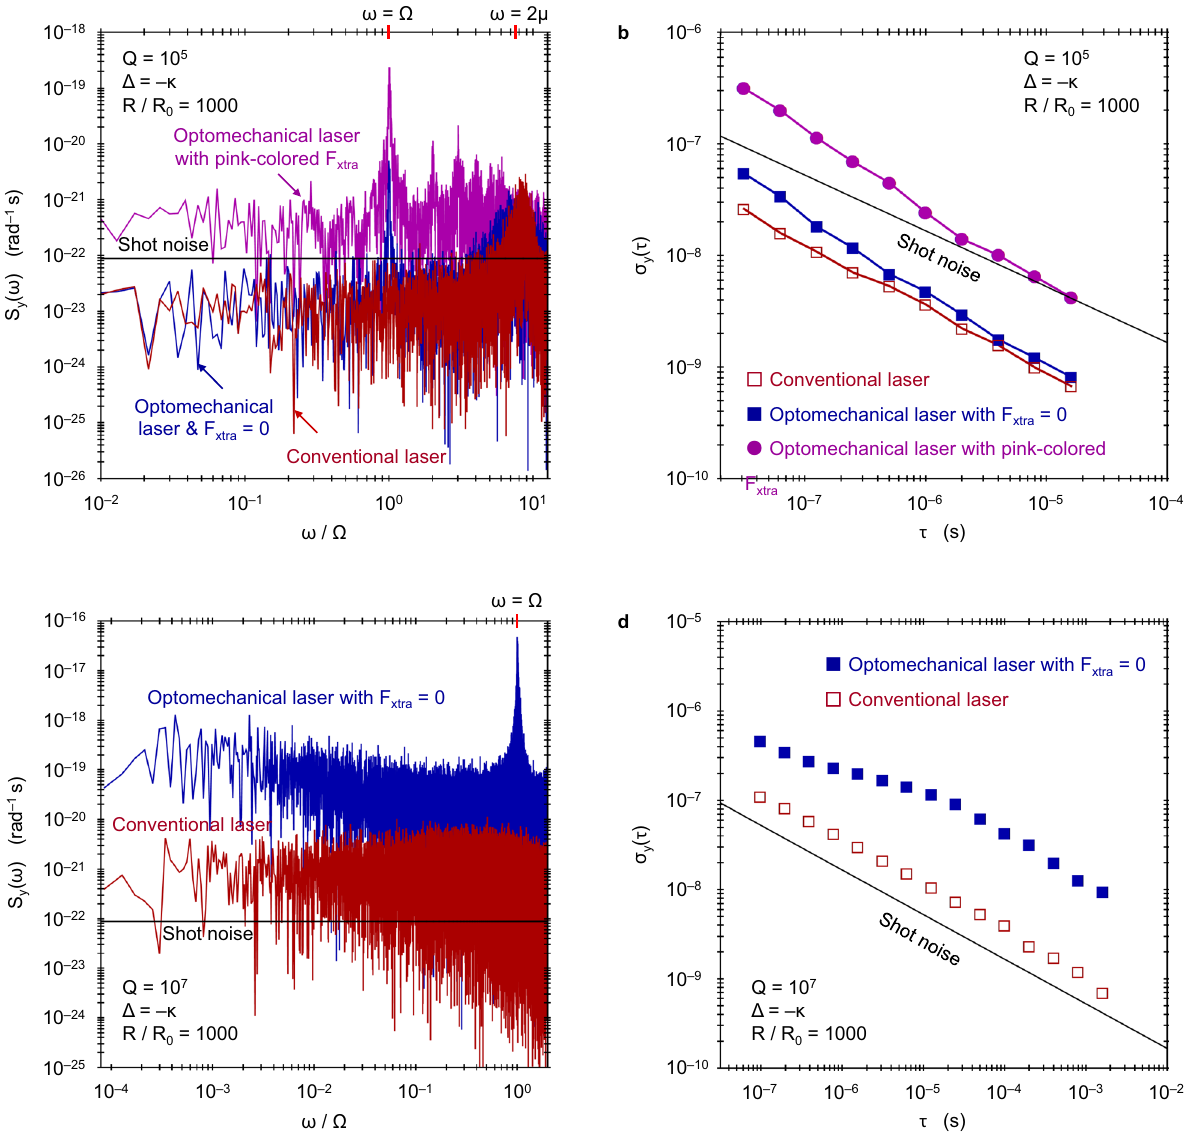
Fig. 4 Frequency stability of the optomechanical laser. a Numerically simulated spectrum S y ð ω Þ of the signal y ð t Þ ¼ ω L ð t Þ = ω A with the perturbed laser frequency ω L ð t Þ and the atomic transition frequency ω A . The optical cavity has a low Q factor of 10 5 . For the optomechanical laser, the optical cavity has a movable mirror. For the corresponding conventional laser, the positions of both cavity mirrors are fi xed. In addition to the photon radiation pressure, an extra environmental noise force F xtra ð t Þ is exerted upon the mechanical oscillator whose oscillation frequency Ω is chosen as the frequency unit. The pink- colored noise force F xtra ð t Þ is chosen as F xtra ð t Þ ¼ 200 _ ξ (cid:10) F ð t Þ with the frequency pull parameter ξ . The spectral density of the noise function F ð t Þ is given by 1 = ω . The pump rate R is set at 10 3 R 0 with the minimum pump threshold R 0 and the atom – cavity detuning is chosen as Δ ¼ (cid:2) κ with the cavity loss rate κ . The spectra S y ð ω Þ under different conditions are plotted. Two spectral peaks are presented in S y ð ω Þ at around ω ¼ 2 μ and ω ¼ Ω with the atom – cavity coupling strength μ and the mechanical oscillation frequency Ω . The corresponding Allan deviations σ y ð τ Þ are shown in b . c , d Spectra S y ð ω Þ and Allan deviations σ y ð τ Þ with a high Q factor of 10 7 under different conditions. For comparison, the shot-noise-limited spectra and Allan deviations have been